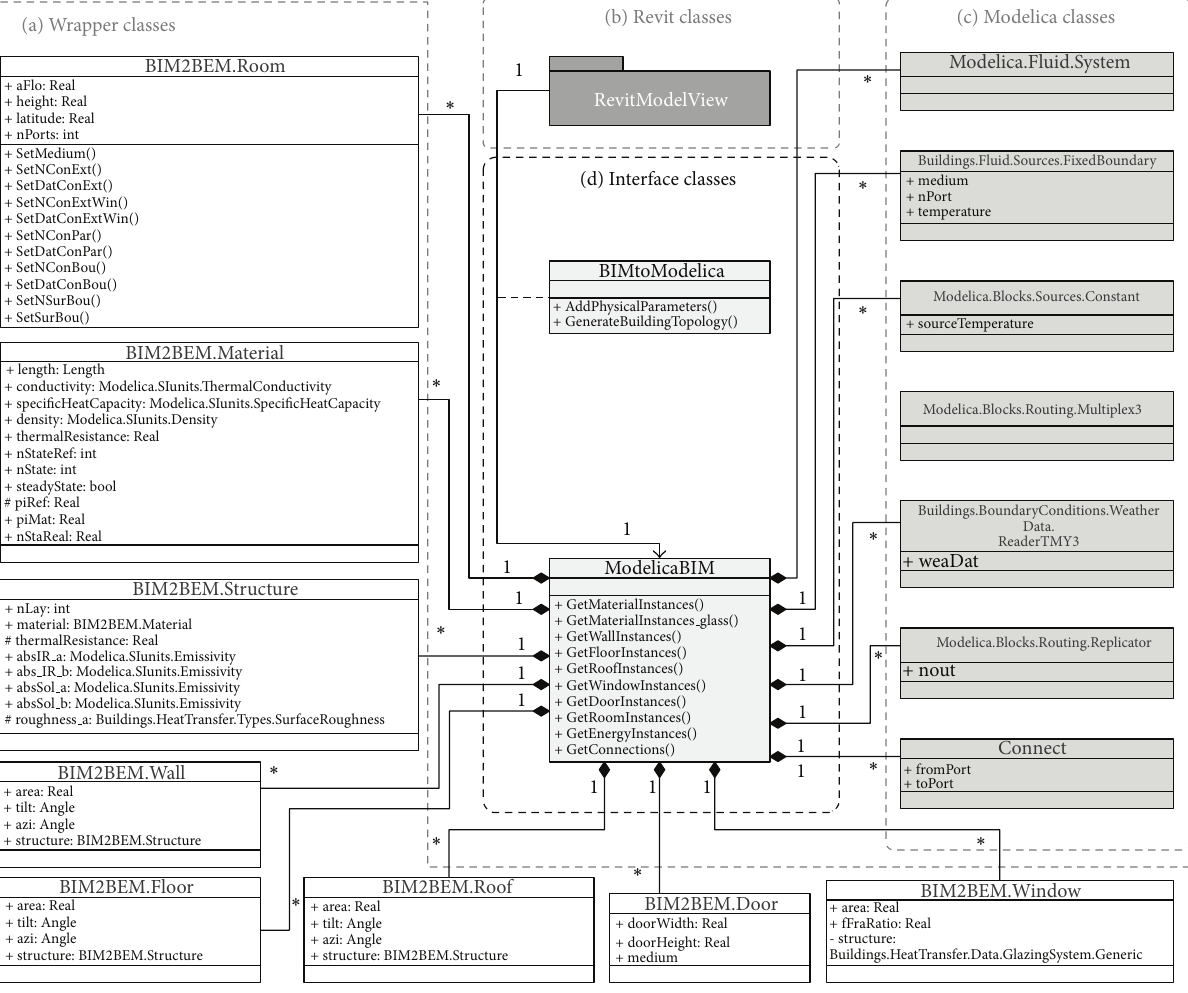
Figure 7: Class diagram of the interface and wrapper